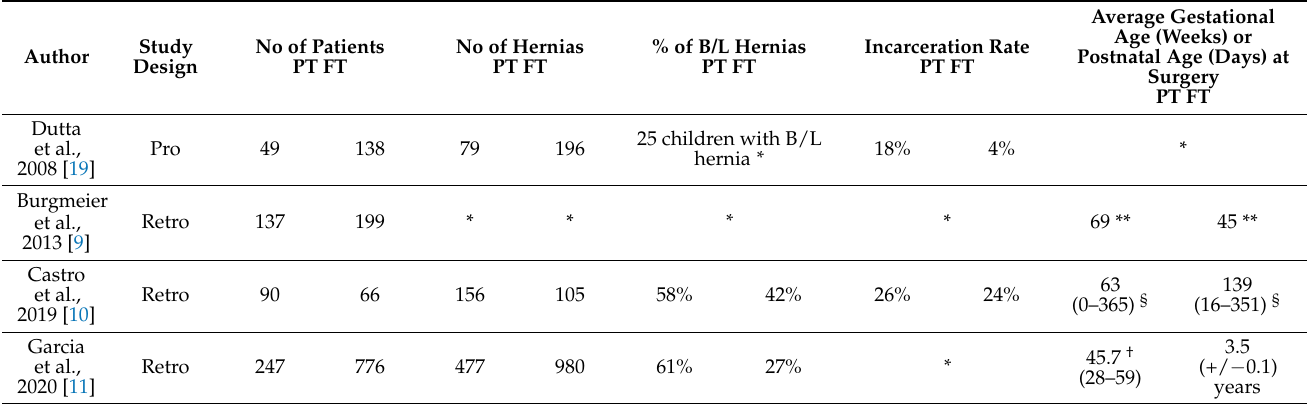
Table 1. Baseline characteristics of the included studies.